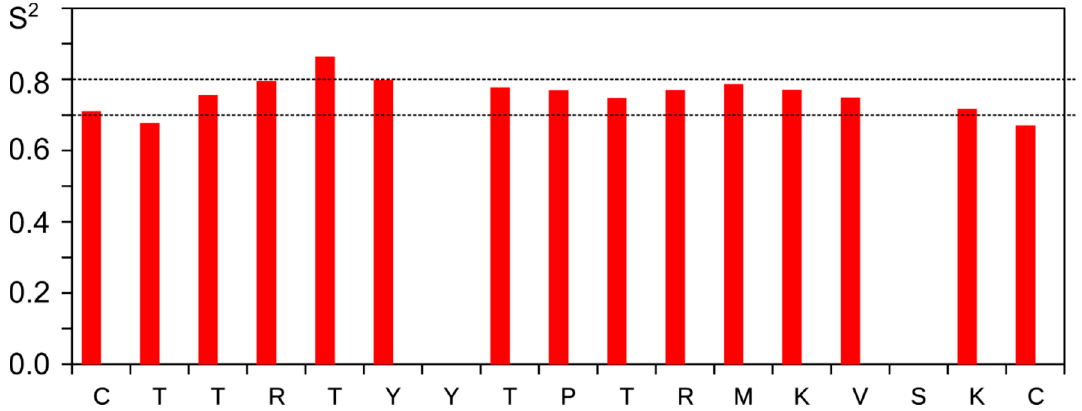
Figure 4. Distribution of C-H order parameters (S 2 ) obtained for Ly29–43 C-C . 3.5. NMR Analysis of Synthetic Analogs of the L. Stagnalis AChBP Loop C